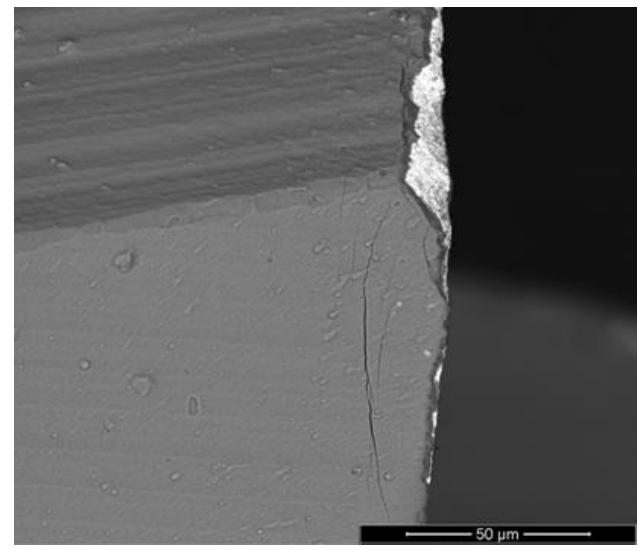
Figure 9. Coating cracking present on the tool’s clearance face for the T1L2F75.